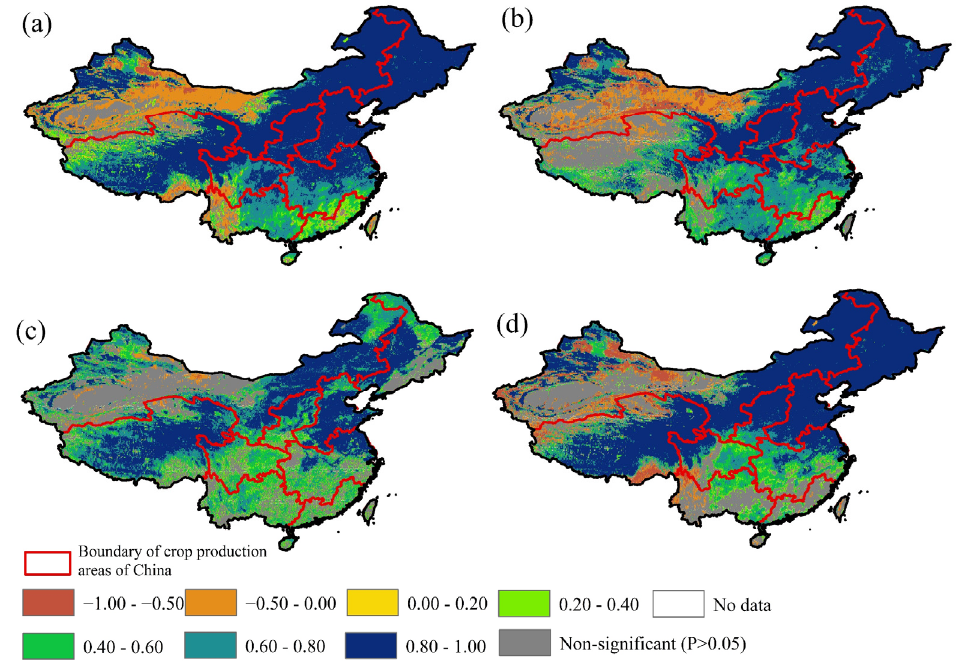
Figure 2. Seasonal spatial distributions of the PCC values obtained between NDVI and SIF: ( a ) growing season; ( b ) spring; ( c ) summer; and ( d ) autumn.